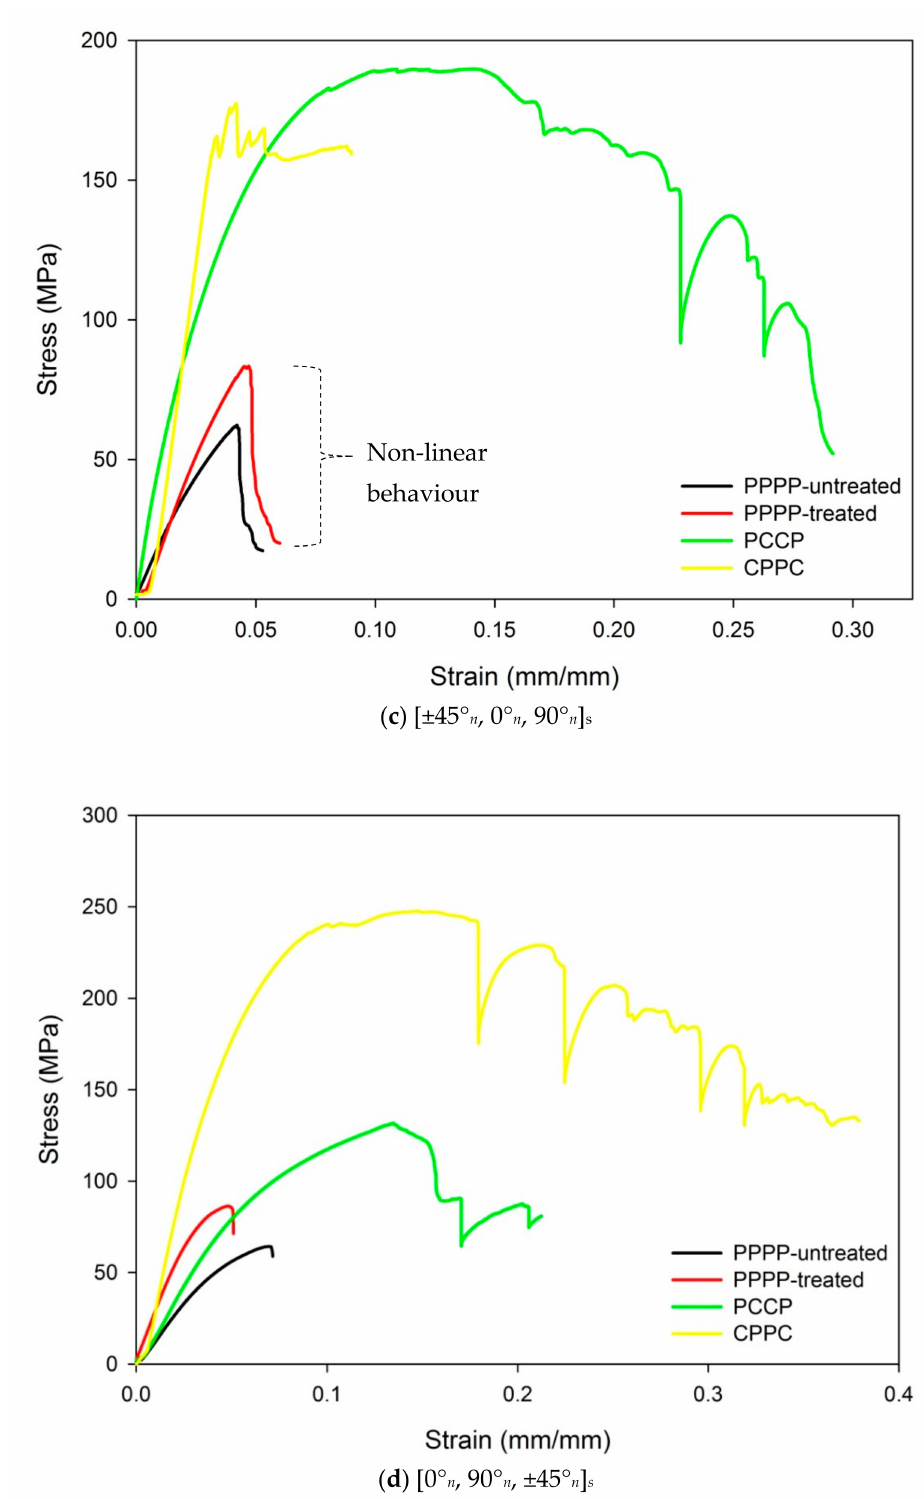
Figure 4. Flexural stress-strain behaviour of PALF/carbon hybrid laminate composites with different material stacking sequences: ( a ) [0 ◦ , 90 ◦ ] n , ( b ) [ ± 45 ◦ ] n , ( c ) [ ± 45 ◦ n , 0 ◦ n , 90 ◦ n ] s and ( d ) [0 ◦ n , 90 ◦ n , ± 45 ◦ n ] s